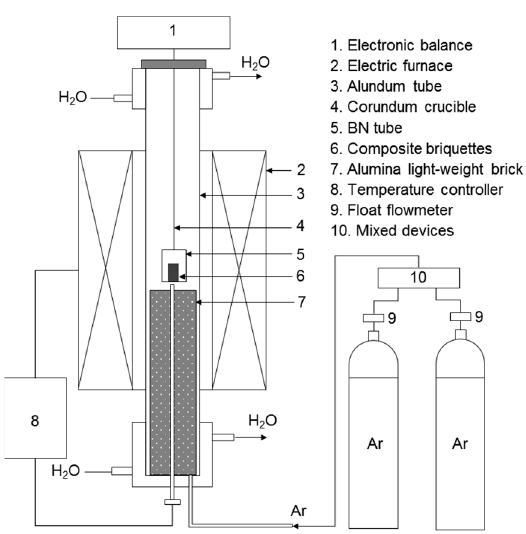
Figure 2. The experimental requirement of the semi-smelting reduction process.